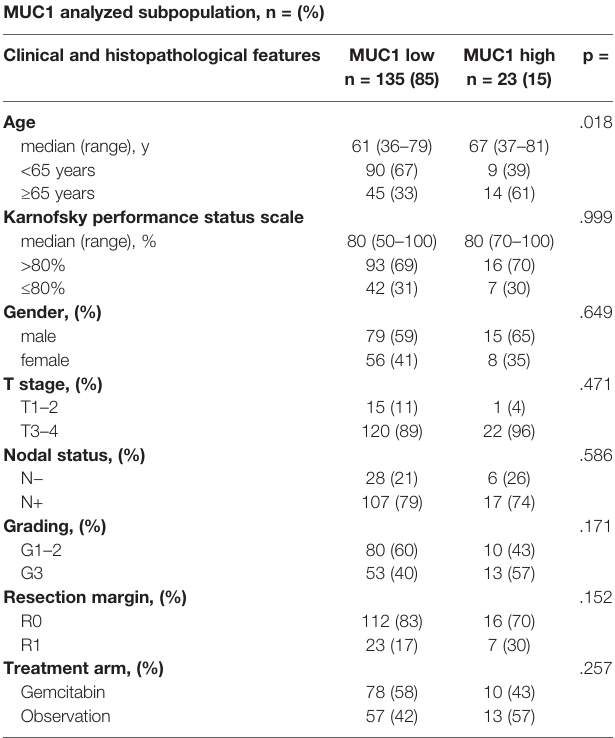
refer to Table 1 : Baseline patients and tumor characteristics .